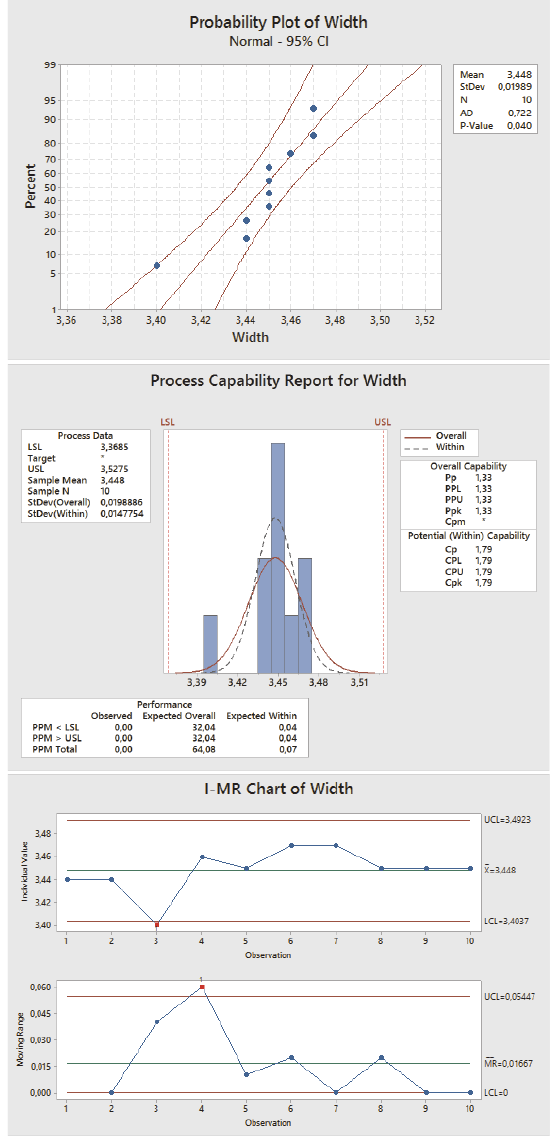
Figure 19: Probability Plot, Process Capability Report and I-MR Chart for the width of